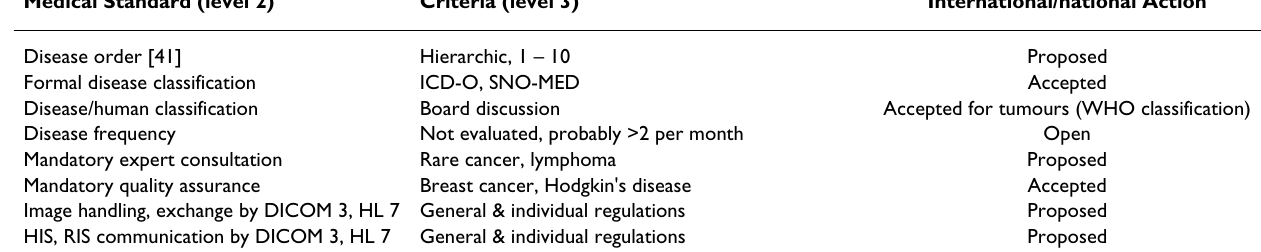
Table 2: A survey of medical standards (level 2 and level 3) suggested or already implemented in tissue-based diagnosis Medical Standard (level